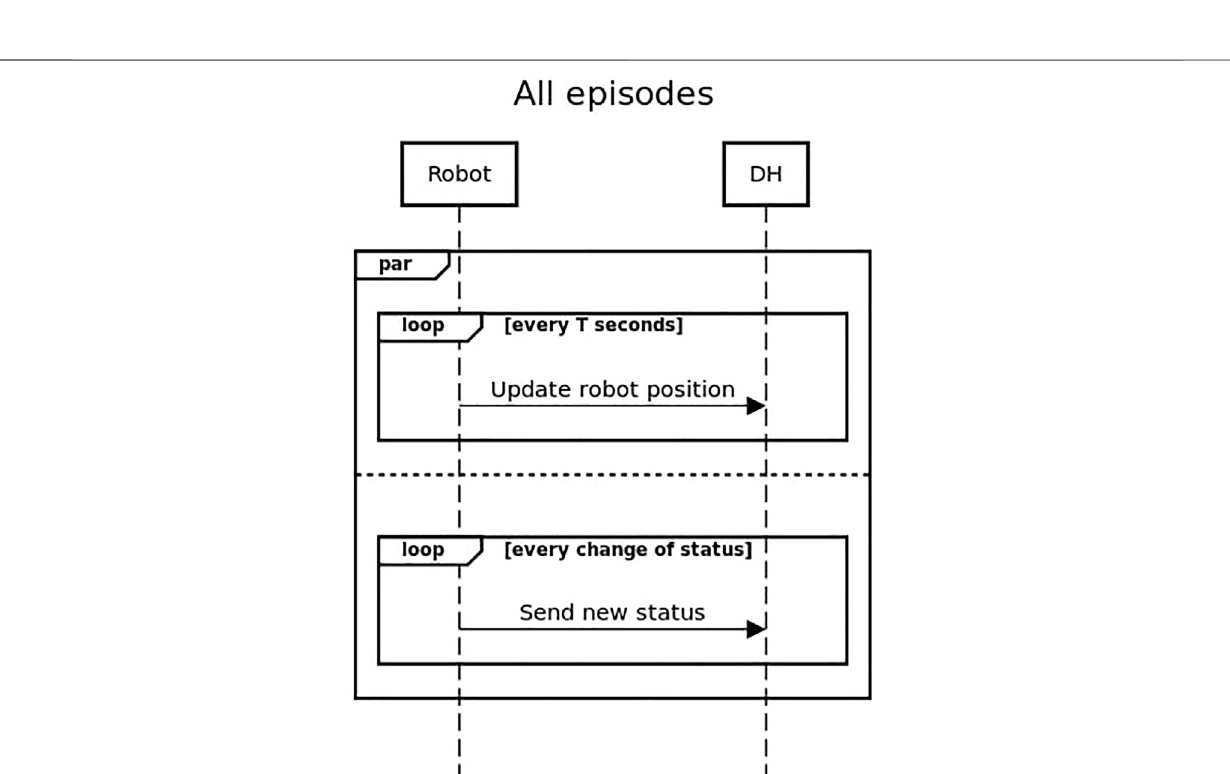
Frontiers in Robotics and AI |